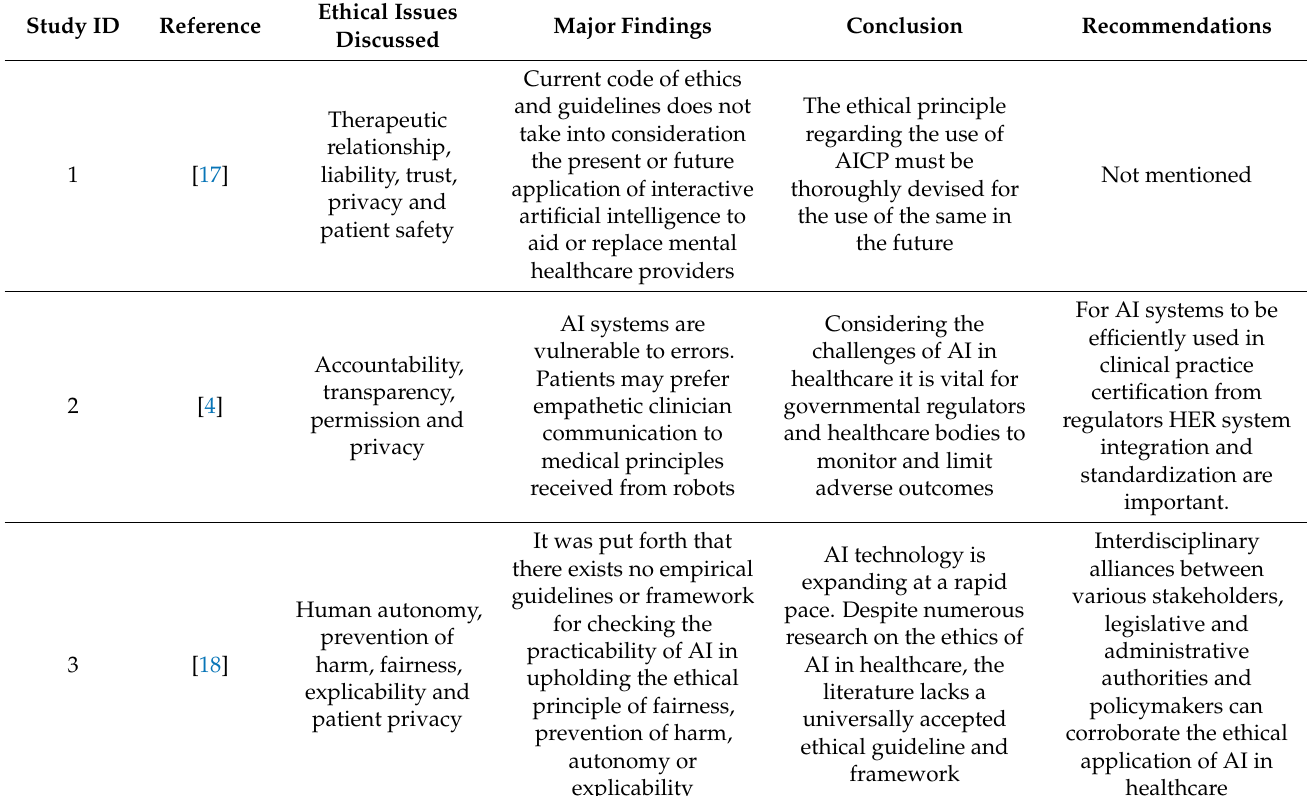
Table 3. Characteristics of data extracted for